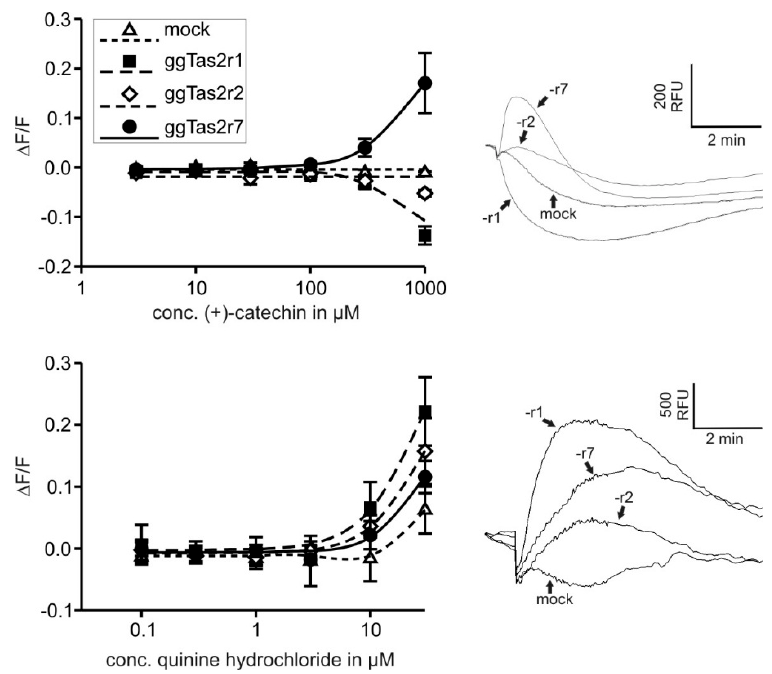
Figure 1. Functional analyses of chicken Tas2rs. The cDNAs of the three chicken Tas2rs were transiently transfected in HEK 293T-G α 16gust44 cells and challenged with different concentrations of (+)-catechin (upper panel) and quinine hydrochloride (lower panel). The changes in fluorescence ( Δ F/F) were monitored and plotted against the log compound concentration ( x -axis). Raw calcium traces obtained with 1000 µ M (+)-catechin (upper right panel) and 30 µ M quinine hydrochloride (lower right panel), respectively, are diplayed next to the corresponding dose-response curves (scale: y -axis, 500 relative fluorescence units (RFU); x -axis, time in minutes (max 2 min)) r1 = ggTas2r1; r2 = ggTas2r2; r7 = ggTas2r7; Mock = empty plasmid which represents negative control).